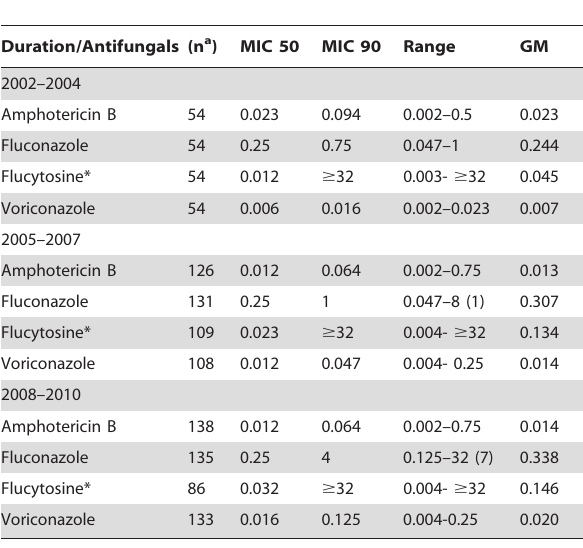
Table 3. Antifungal susceptibility profile of Candida dubliniensis